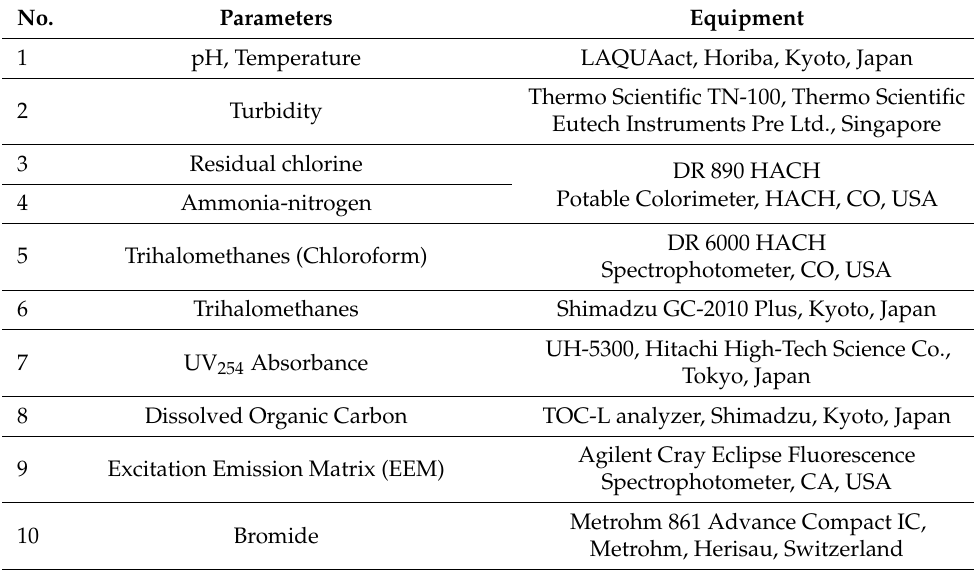
Table A1. Equipment for water quality